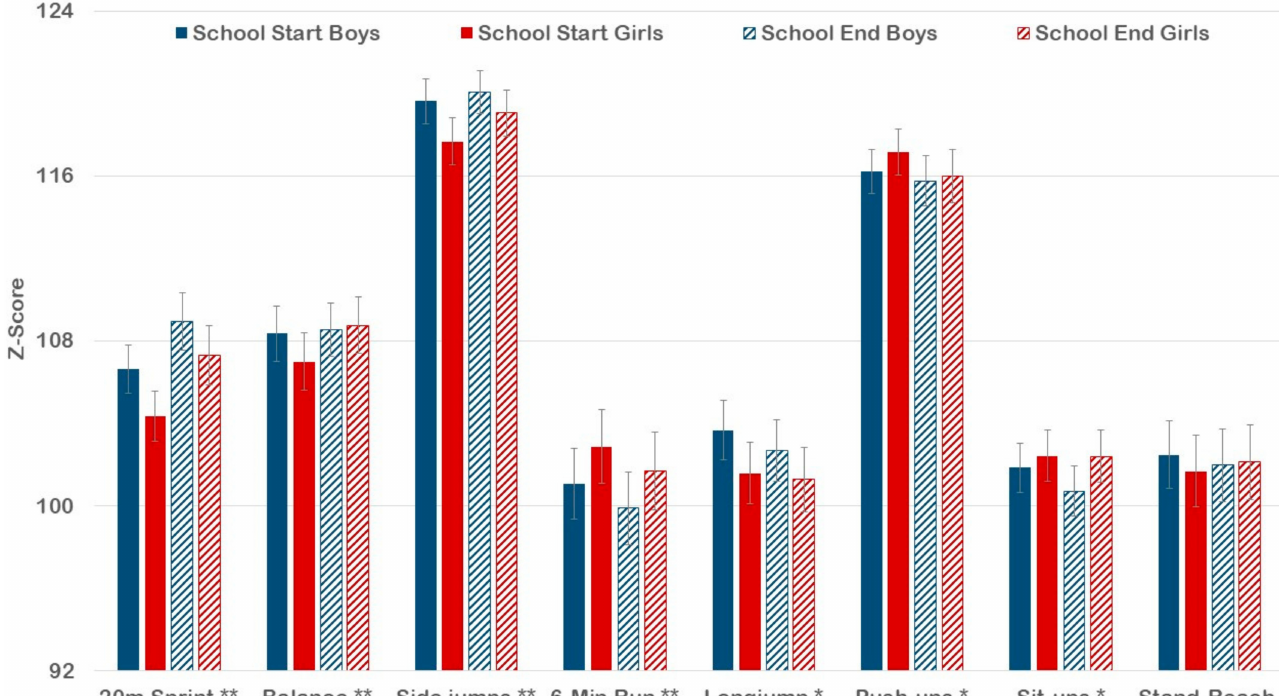
Figure 2. Physical fitness at the beginning and end of the school year based on age- and sex-standardized values for boys and girls. The values represent the mean with a 95% confidence interval. p value for difference between school start and end of school year across total sample: * p < 0.05, ** p <